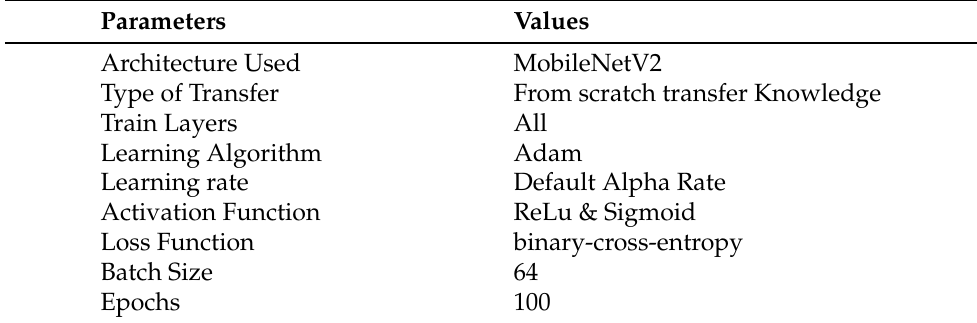
Table 4. Parameters used in the Experiment